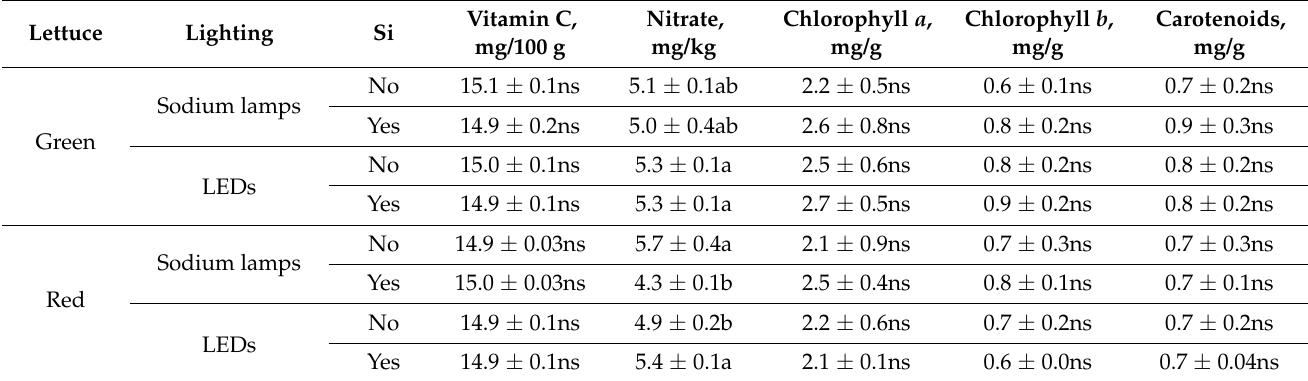
Table 4. Averaged concentrations of sucrose, vitamin C, and nitrates in green and red lettuce ( Lactuca sativa L.) under the conditions of a regulated agroecosystem on the 30th day of cultivation. Values represent mean ± SE ( n = 12). The different letters indicate significant differences among treatments and ns means non-significant differences among treatments according to Duncan’s test ( p ≤ 0.05).